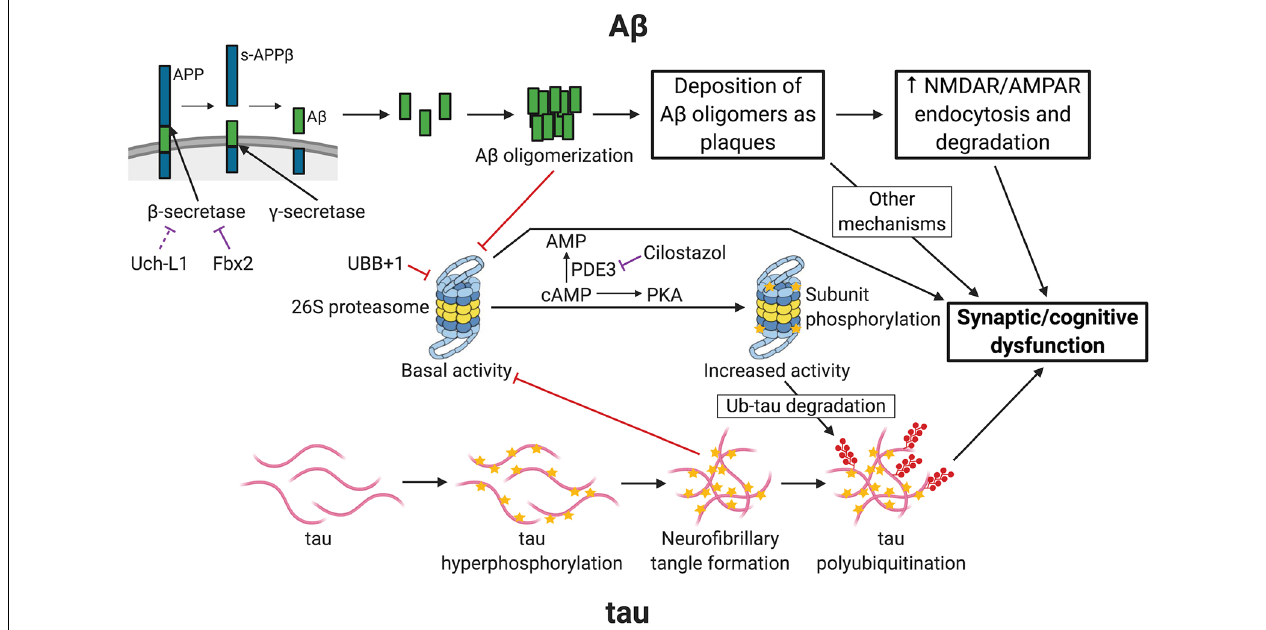
FIGURE 1 | Links between Alzheimer’s disease (AD) and ubiquitin-proteasome-mediated degradation. The figure depicts the pathogenesis of AD and the resultant synaptic/cognitive dysfunction via A β and tau, the two main postulated mechanisms of AD. The connections between the ubiquitin-proteasome pathway (UPP) and the components of the two pathways are indicated. Only key relevant features of AD pathogenesis are shown. Processes with a purely inhibitory effect are shown by red connectors. Negative regulatory mechanisms with potential for therapeutic intervention are shown by purple connectors. APP, amyloid precursor protein; s-APP β , soluble N-terminal APP fragment; PDE3, phosphodiesterase 3; PKA, Protein Kinase A (cAMP-dependent protein kinase); Ub-tau, tau with attachment of many ubiquitin (Ub) molecules (i.e., polyubiquitinated tau); stars indicate phosphorylation; shapes with filled red circles with tails represent polyubiquitin attachment. Created with